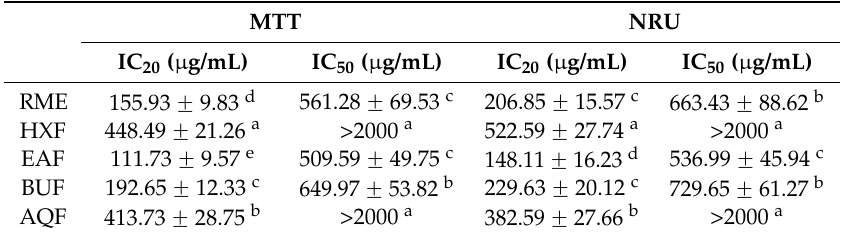
Table 4. IC 20 and IC 50 values obtained by the MTT and NRU